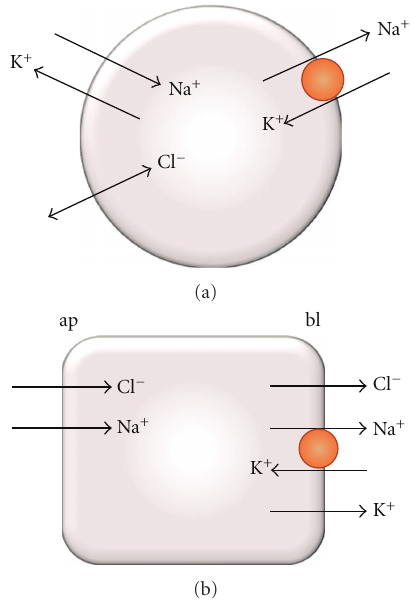
Figure 3: Schemes showing some ionic transport systems of the plasma membrane. (a) In symmetric, nonpolarized cells the sod- ium pump maintains the electrochemical gradients of sodium and potassium across the plasma membrane. The sodium and potas- sium channels underlie the generation of a di ff usion potential across the plasma membrane. Chloride is usually maintained at activities close to equilibrium. (b) In polarized epithelial cells the asymmetric distribution of, mainly, sodium channels and the sodium pump into distinctive apical and basolateral membranes may determine a net transcellular transport of sodium chloride. (ap: apical; bl: basolateral; the orange circles represent the sodium pump, and the other arrows correspond to ionic